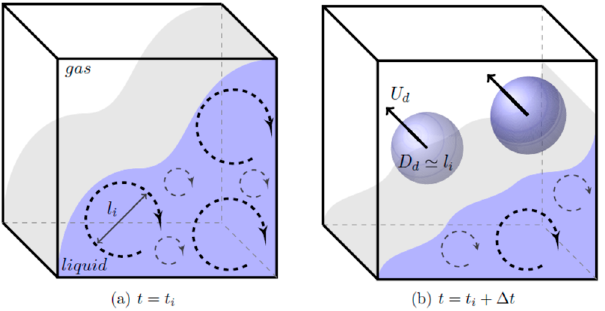
Figure 13. Physical picture of droplet ejection in the modeling [61]. The eddies in the liquid phase play an important role in droplet generation. Reproduced with permission from Elsevier.